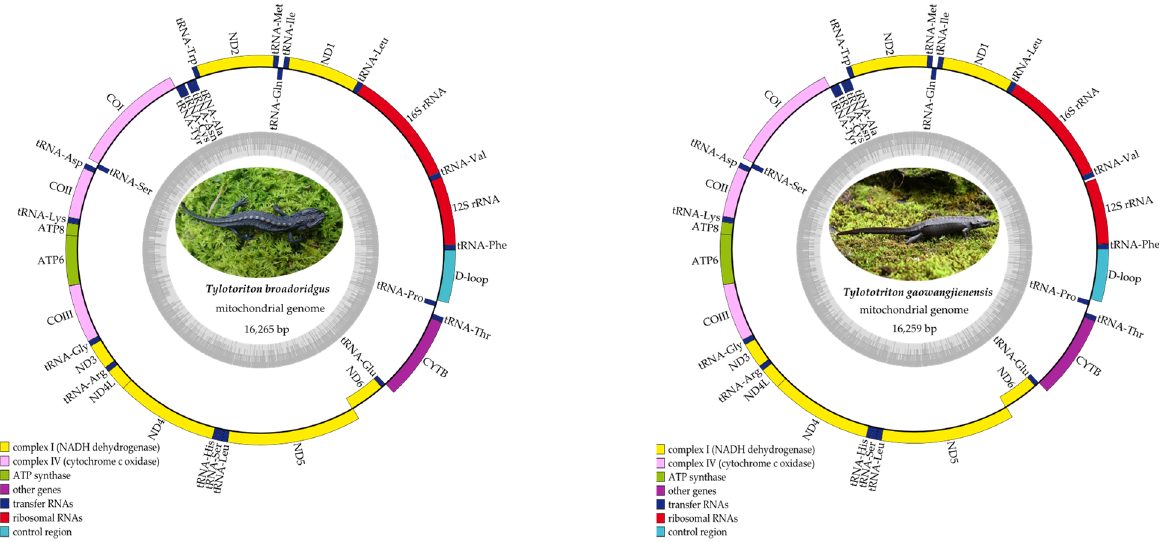
Figure 1. Gene maps of the two newly sequenced Tylototriton species. Table 1. Mitochondrial genome organization of T. broadoridgus (TB) and T. gaowangjienensis (TG). Each of the PCGs of the two species was identical in length, but with different